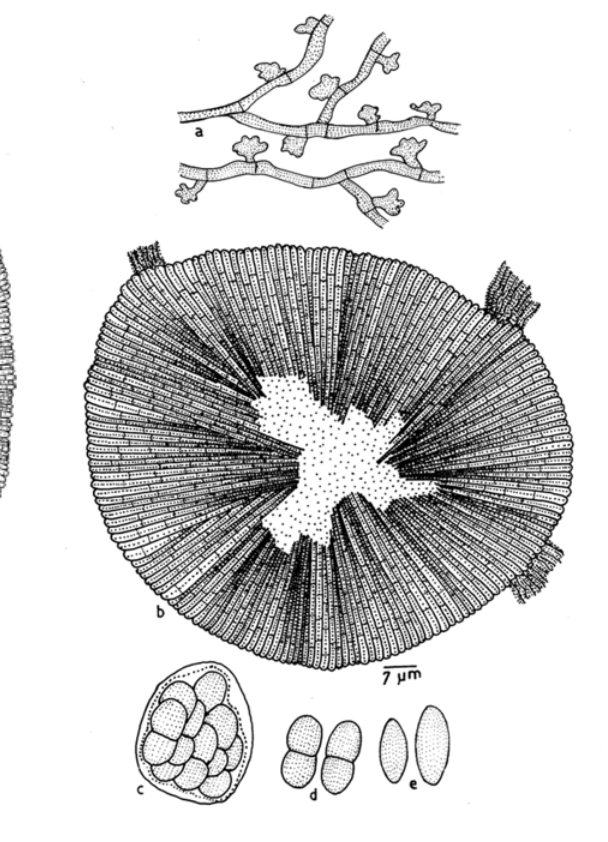
Figure 151. Asterina ligustricola a - Appressorium; b - Thyriothecium; c - Ascus; d - Ascospores; e -